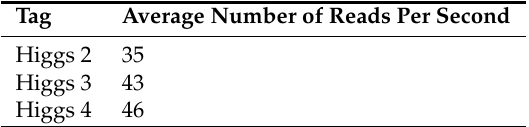
Figure 14. A photo of a measurement setup in a retail store, Impinj reader, SDR, and tag on a product. Table 5. Impinj reading results along the measurement trajectory of a tag attached to a cardboard.